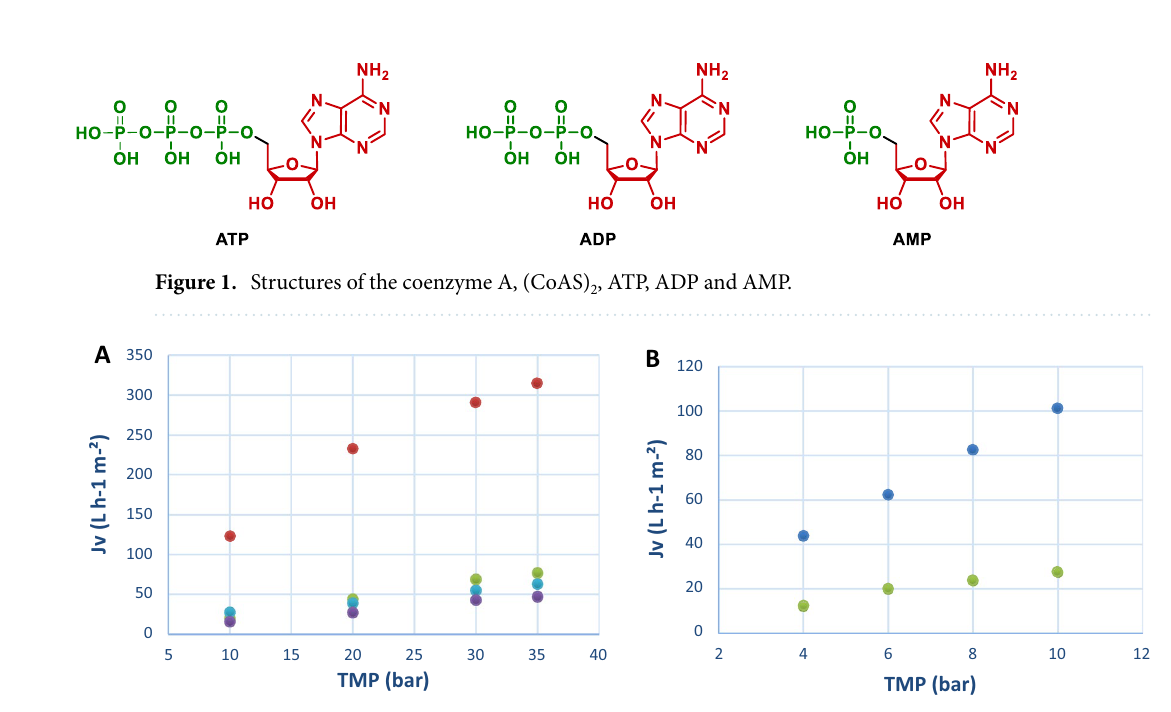
Figure 2. Effect of pressure (TMP) on permeate flux (J v ) for membranes screened with model solution. ( A ) ( ) NP010, ( ) GE, ( ) 7450, ( ) 7470 PHT. ( B ) ( ) GK, ( )